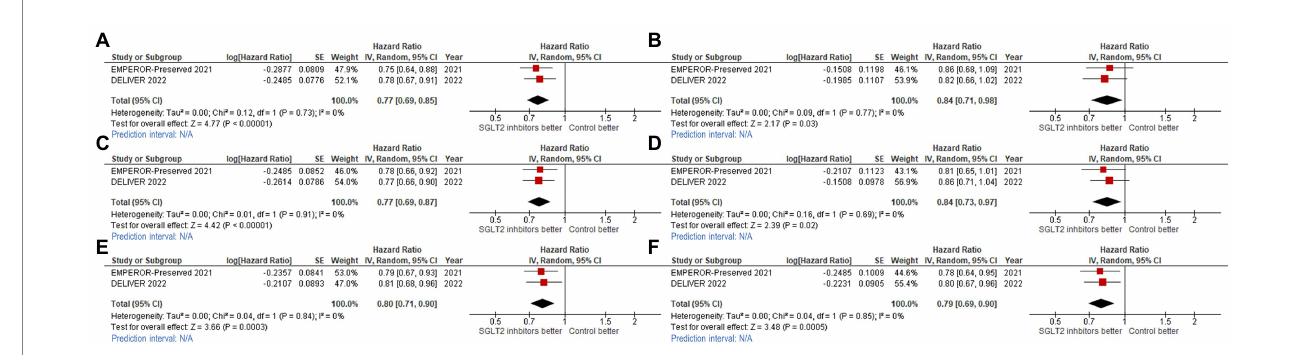
FIGURE 5 Forest plots of studies that compared cardiovascular (CV) death/hospitalization for heart failure (HHF) outcome among patients receiving sodium-glucose cotransporter-2 (SGLT2) inhibitors versus controls in patients with (A) New York Heart Association functional class II (NYHA II); (B) NYHA III-IV; (C) estimated